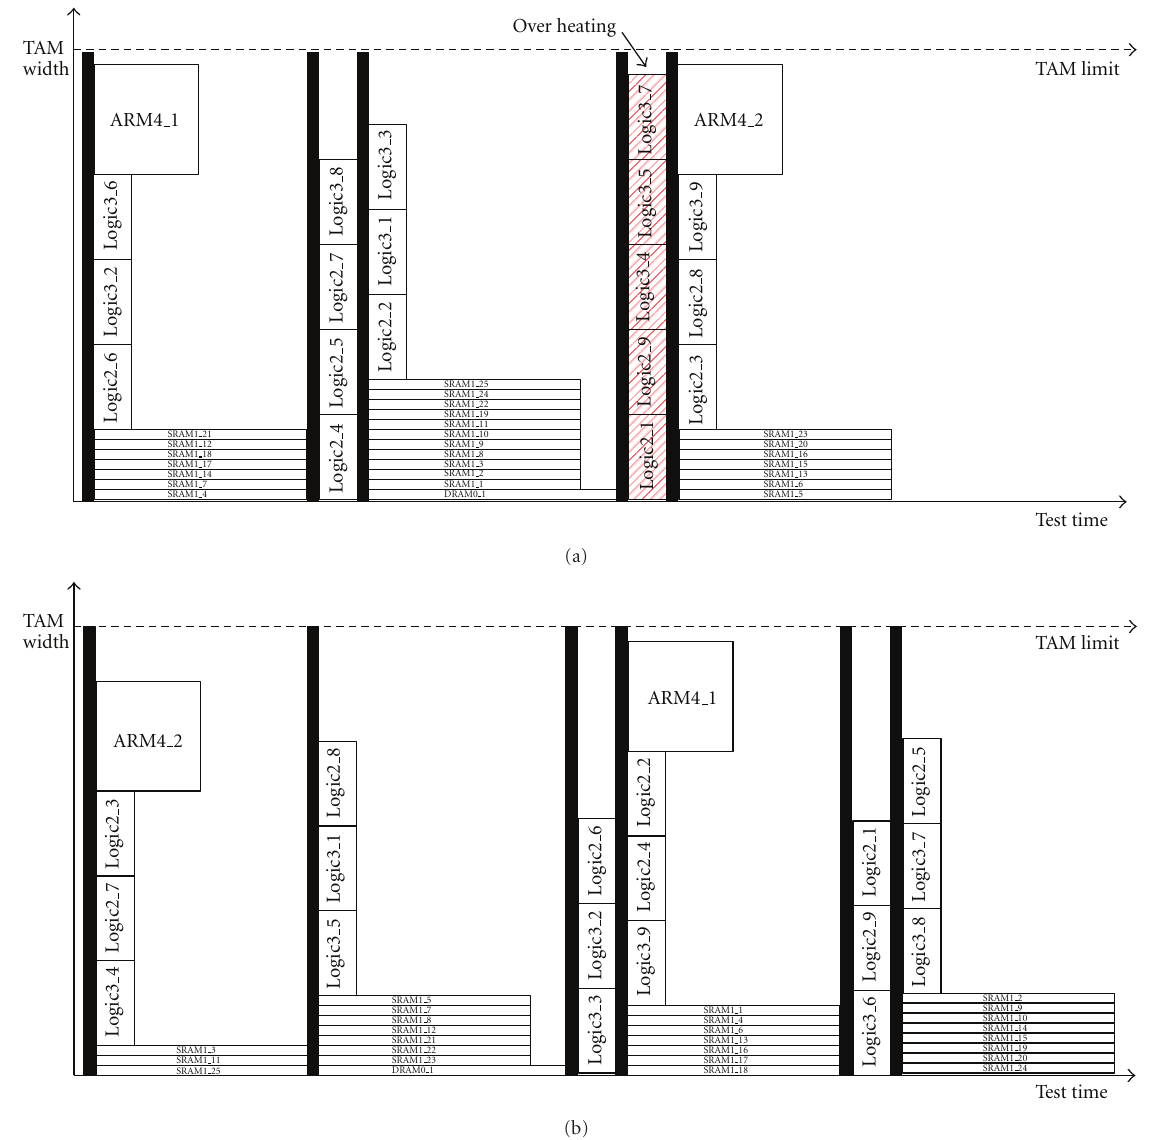
Figure 1: An example test schedule: (a) without temperature constraint and (b) with temperature